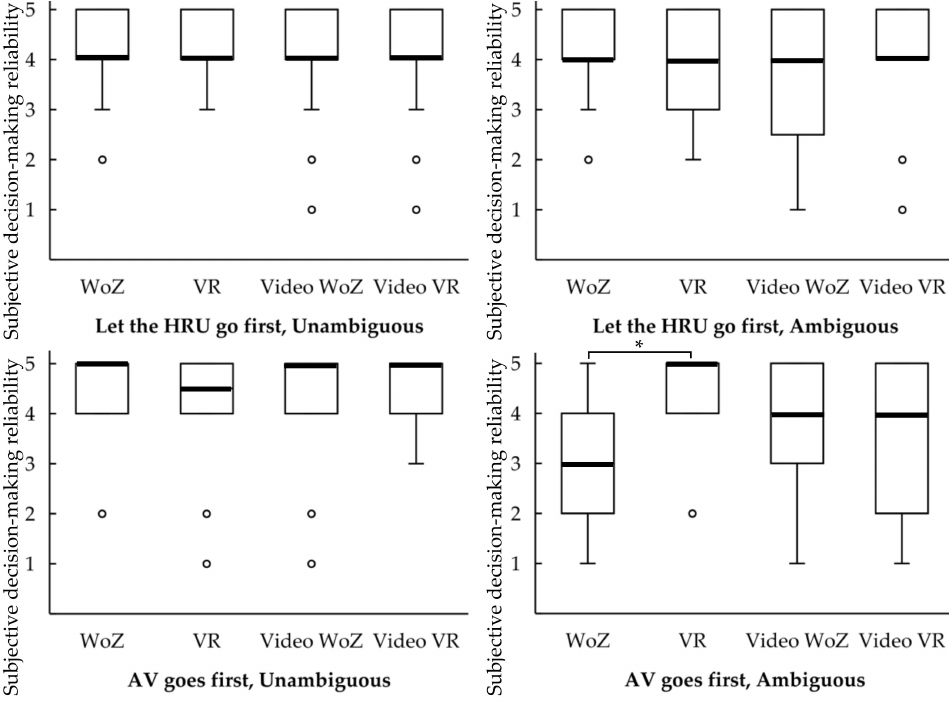
Figure 9. Boxplots for the subjective decision-making reliability (1 = very uncertain; 5 = very certain), segregated by setup (* = p <